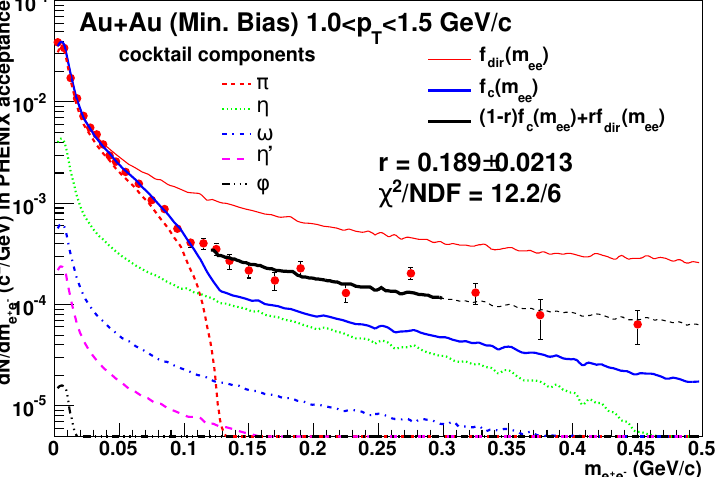
Figure 6. Dilectron mass distribution for Au–Au (min. bias) events for 1.0 < p T < 1.5 GeV/ c . The two-component fit with function f ( m ee ) is explained in the text. The fit range is 0.12 < m ee < 0.3 GeV/ c 2 . The dashed black curve at greater m ee shows f ( m ee ) outside of the fit range